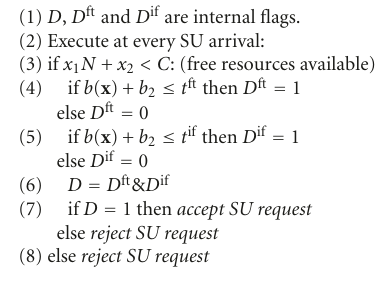
Figure 5: Admission control scheme for SUs.